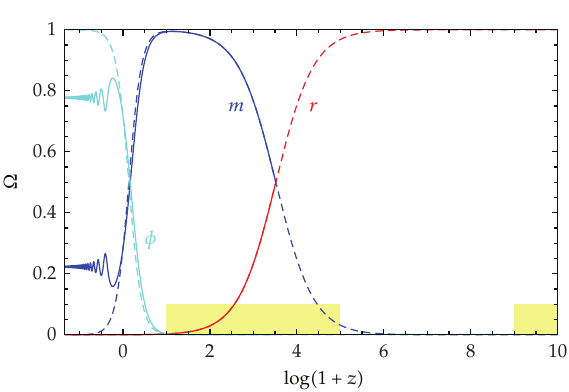
(cid:2) 1 (cid:10) z (cid:3) for the potential V (cid:9) A (cid:2) 1 (cid:10) cos (cid:2) ϕ (cid:3)(cid:3) , ϕ i /π (cid:9) 0.5 (cid:2) solid (cid:3) versus Λ CDM Figure 10: Ω versus log 10 (cid:2) dotted (cid:3)